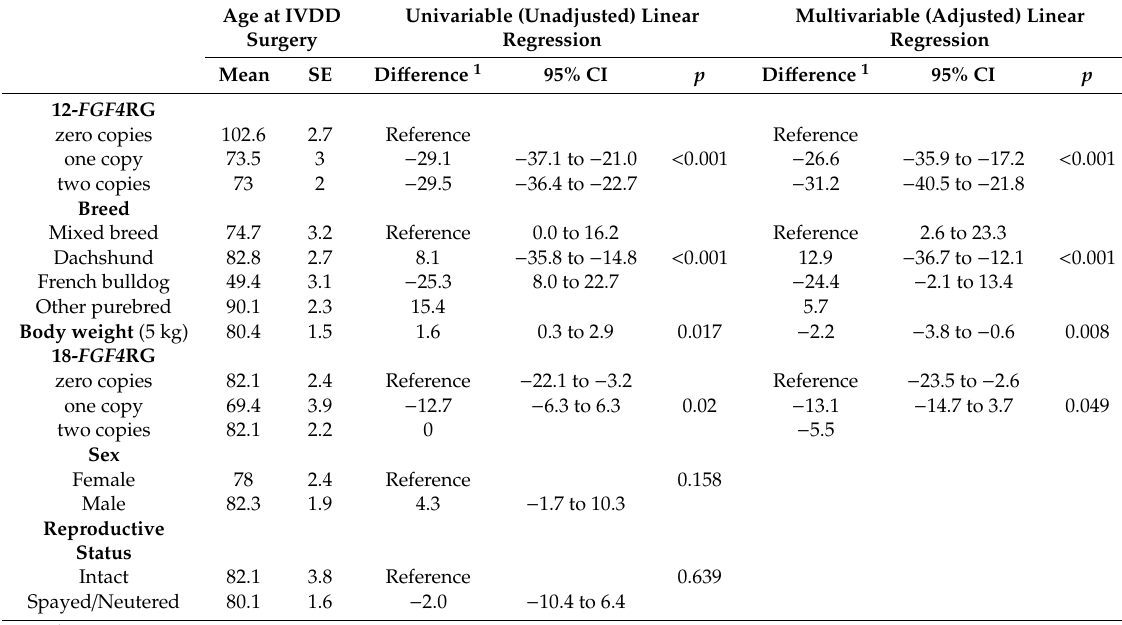
Table 2. Linear regression identifying characteristics associated with age at time of surgery. Standard Error (SE); Confidence Interval (CI). Age at IVDD Univariable (Unadjusted) Linear Multivariable (Adjusted) Linear Surgery Regression